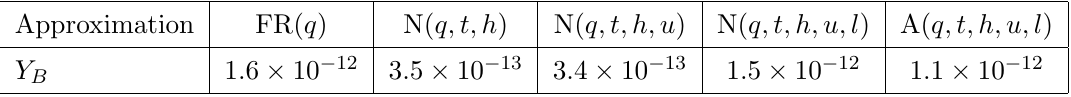
Table 3 . Baryon asymmetry Y B for a top source using di(cid:11)erent approximations discussed in the main text. We used the benchmark values for the bubble-wall pro(cid:12)le given in section 2.1 and (cid:3) t = 7 : 1 TeV consistent with EDM